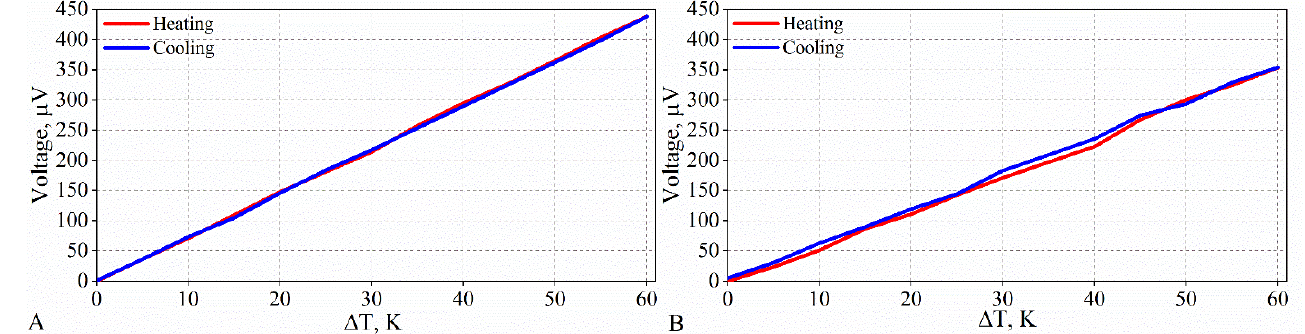
Figure 13. Changes in thermoelectric voltage with temperature gradient during heating and cooling of composites with content of ( A ) 3 wt% and ( B ) 2